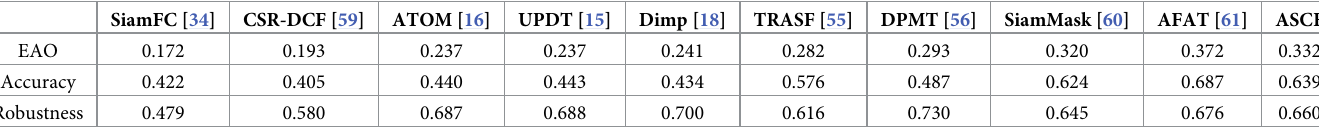
Table 4. Experimental results on VOT2020-RT dataset.